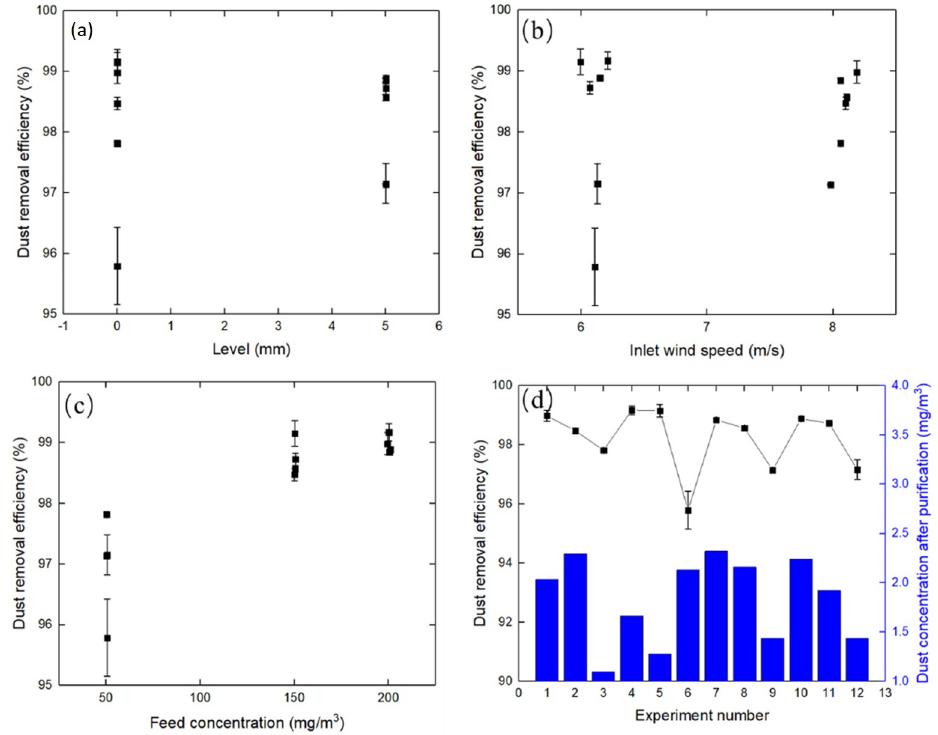
Table 5. Initial liquid level, inlet airflow velocity, and feeding concentrations selected for the present study.